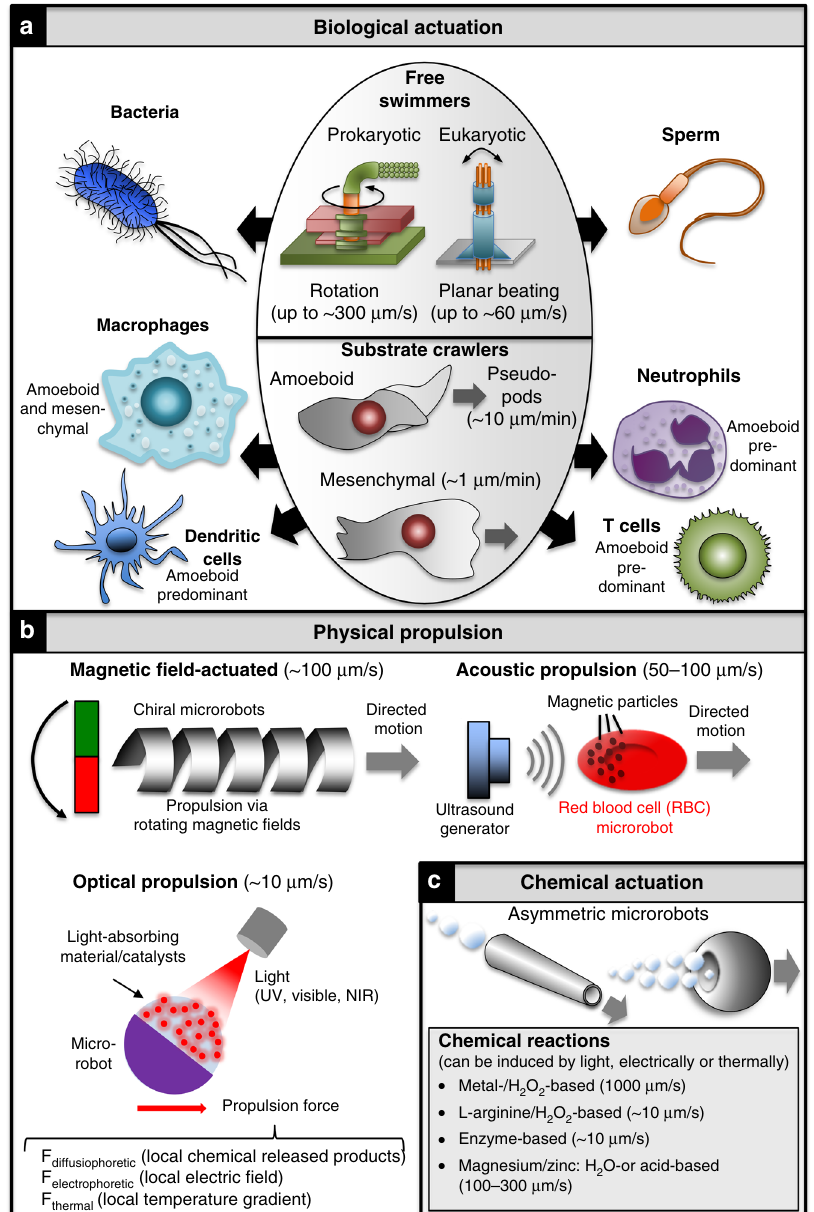
Fig. 3 Mechanisms of actuation for microrobots. Key examples for a biological migration modes, b physical propulsion and c chemical